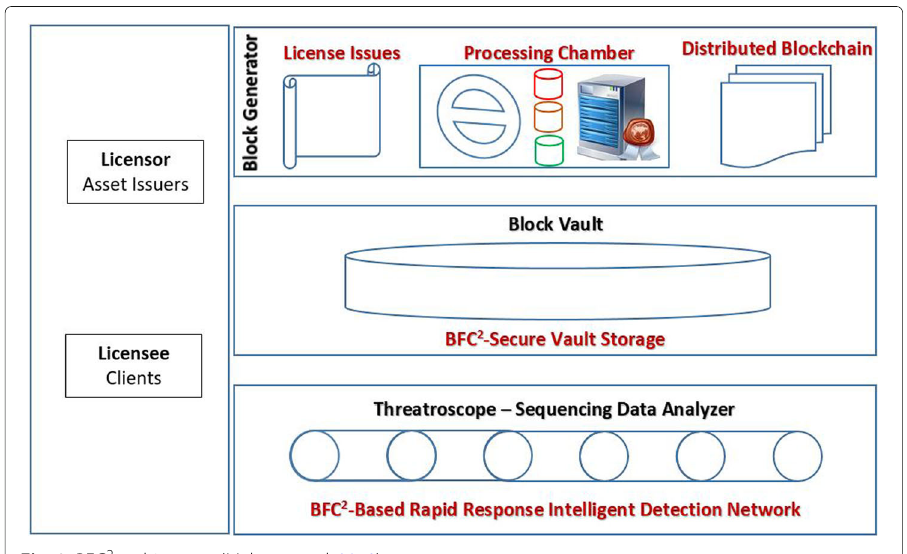
Fig. 2 BFC 2 architecture (Malomo et al.